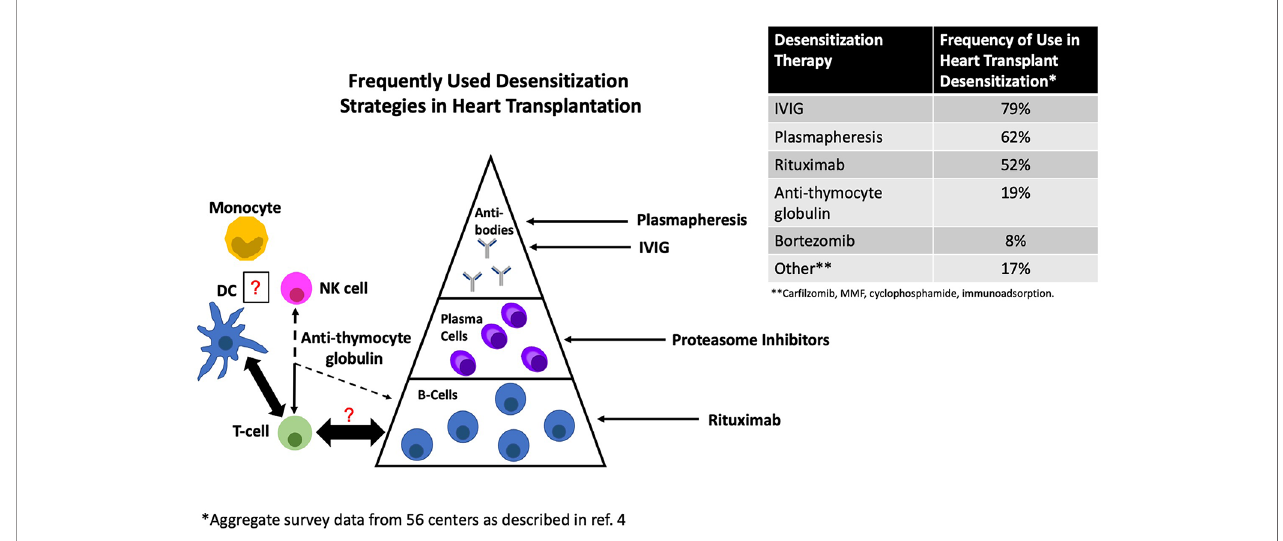
FIGURE 1 | Common approaches to desensitization in heart transplantation and their primary site of action. DC, dendritic cell; NK, natural killer